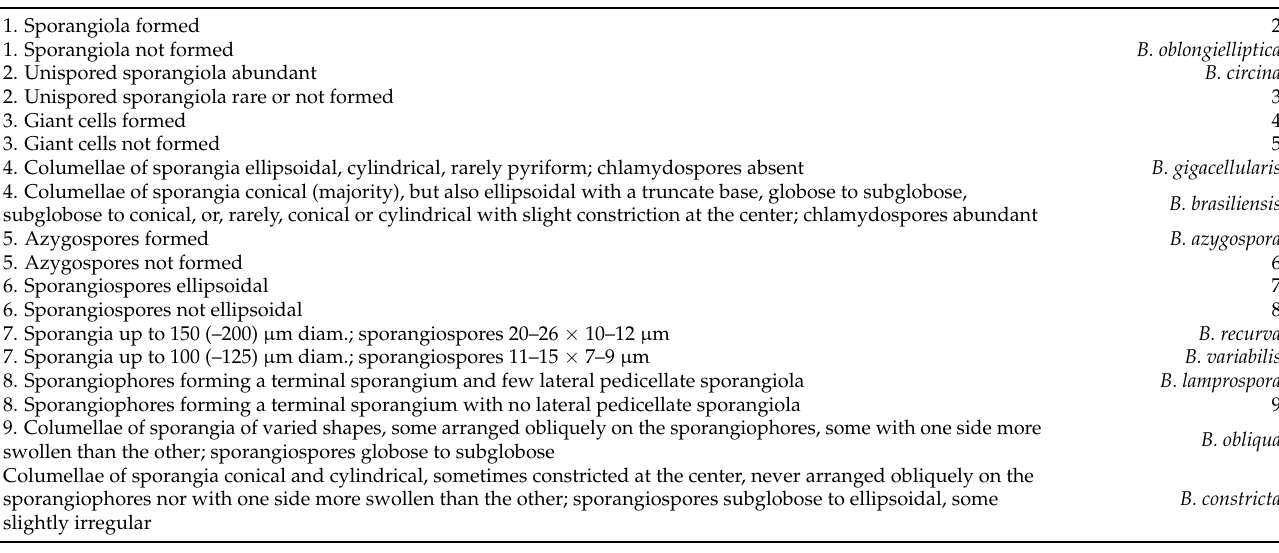
Table 2. Identification key for species of Backusella in the